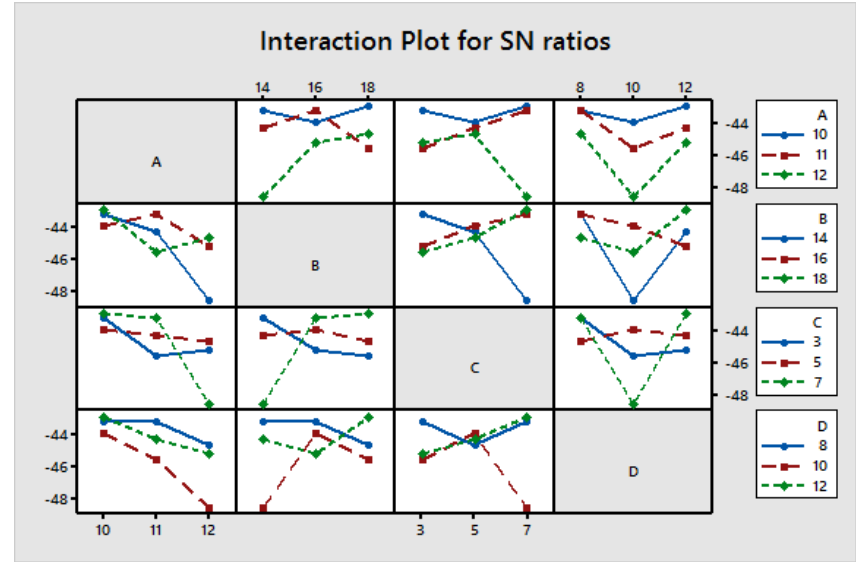
Figure 8. Interaction plot for S/N ratios [Response: Diameter]. Table 6. Analysis of variance for S/N ratios.